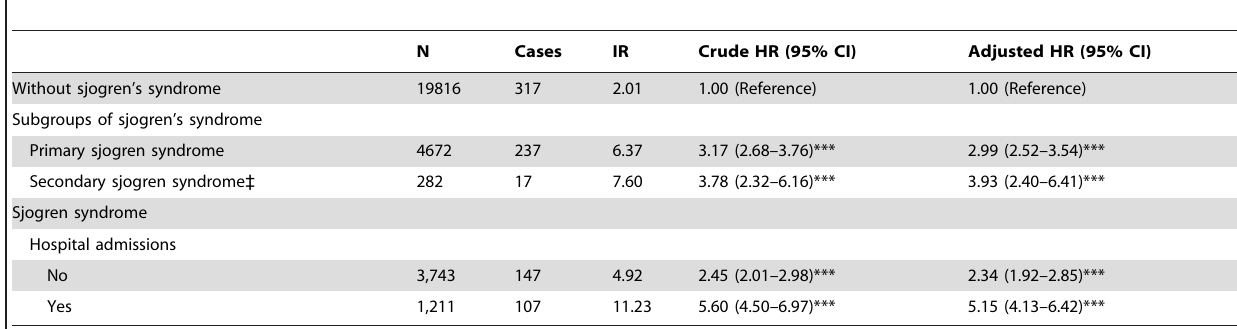
Table 4. Incidence and adjusted hazard ratio of respiratory failure in different subgroups and severity sjogren syndrome.